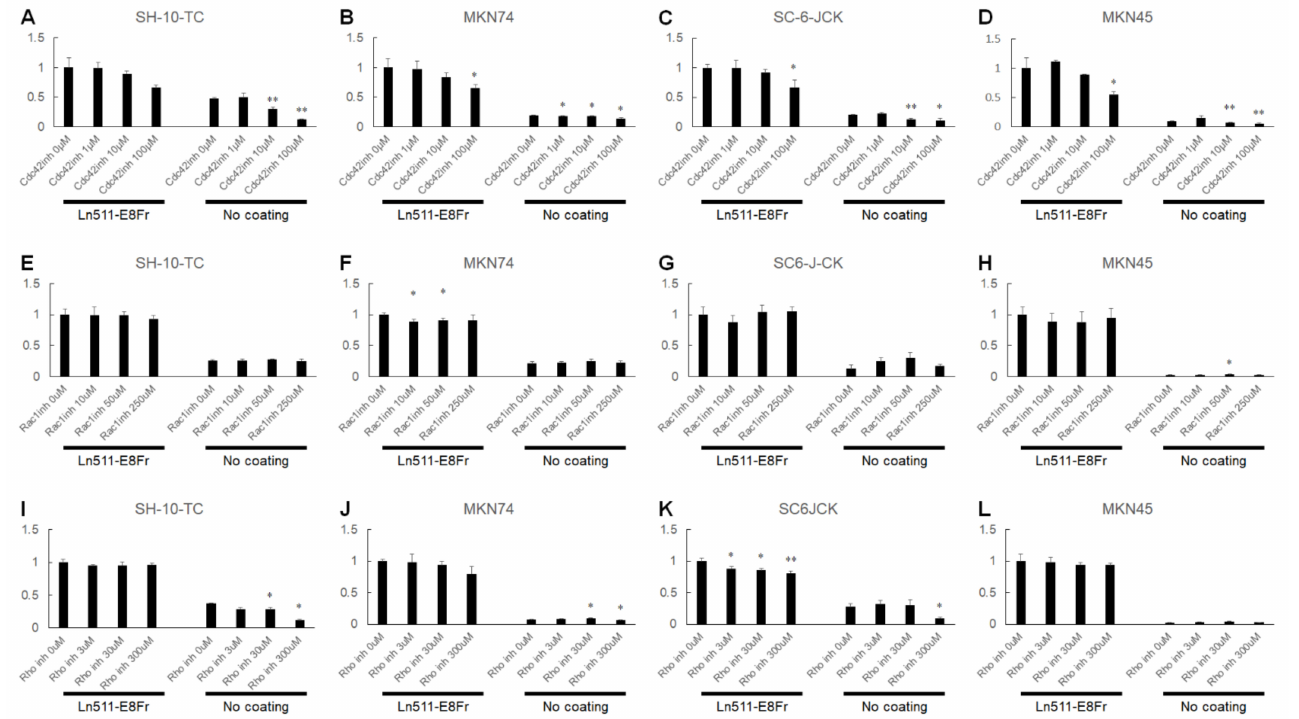
Figure 8. The percentages of adhesive cells at 1 h after seeding in the presence of the Cdc42 GTPase, Rac1, or Rho inhibitors. Adhesion of SH-10-TC ( A ), MKN74 ( B ), SC-6-JCK ( C ), and MKN45 cells ( D ) to the Ln511-E8 fragment-coated plates was reduced owing to the Cdc42 GTPase inhibitor in a dose- dependent manner, suggesting possible involvement of Cdc42 in superior gastric cancer adhesion to the Ln511-E8 fragment. The Rac1 inhibitor had no inhibitory effects on cell adhesion ( E – H ). The Rho inhibitor resulted in dose-dependent decrease in adhesion of SC-6-JCK cells ( K ). The Rho inhibitor had no inhibitory effects on cell adhesion of SH-10-TC ( I ), MKN74 ( J ), or MKN45 cells ( L ). * p < 0.05, ** p < 0.01, as indicated (vs. no coating). Data are presented as the mean ± standard deviation of three independent experiments. Values are normalized to those of controls (no